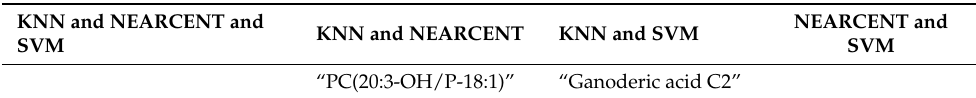
Table 13. Common metabolites found in each model for